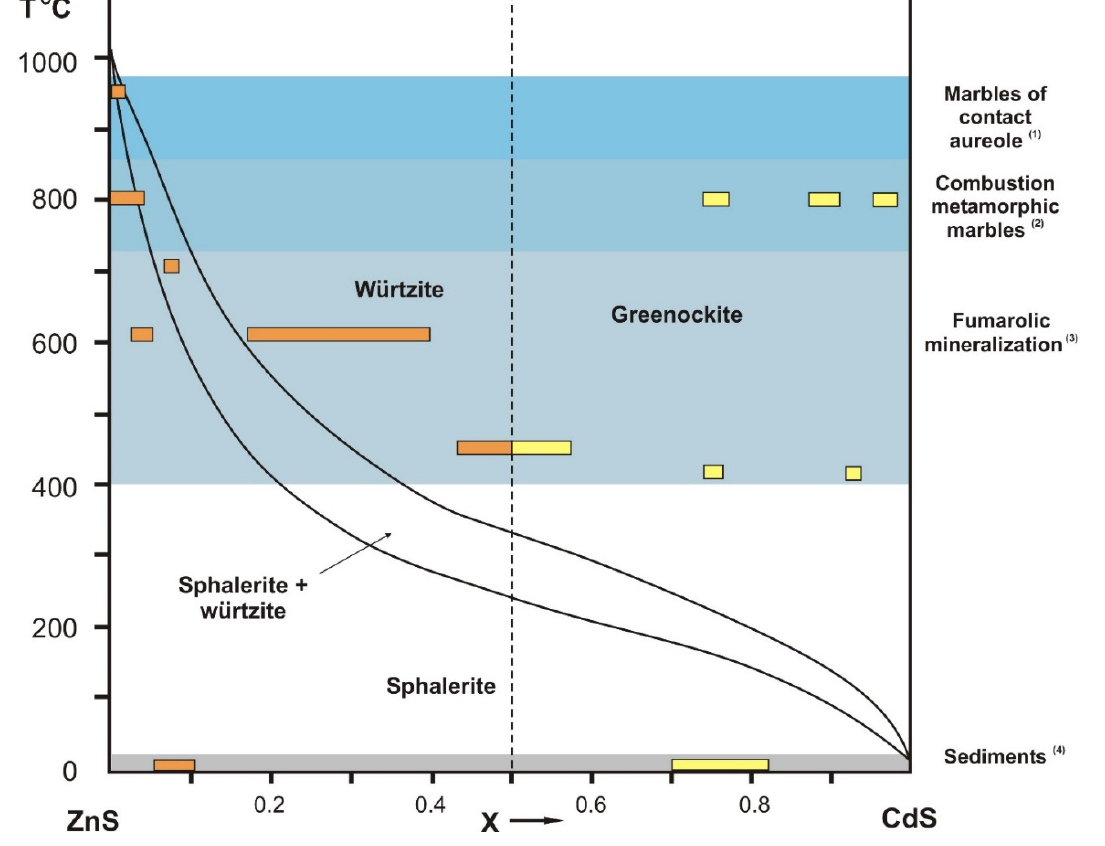
Figure 14. Phase diagram of the system ZnS–CdS; x—the molar fraction of Cd in Zn 1 − x Cd x S solid solution. Phase boundaries after [77]. Orange (sphalerite and würtzite) and yellow (greenockite) colors show the composition ranges of sulfides from different rock types: (1) spurrite marbles from Kochumdek contact aureole (Podkamennaya Tunguska Basin, East Siberia), after [73]; (2) CM marbles from Tulul Al Hammam area (Daba-Siwaqa complex, Central Jordan), this study; (3) fumarolic mineralization of Kudriavy volcano (Iturup Island, Kuriles), after [74]; (4) immature organic-rich siliceous chalks (‘oil shales’) of the Muwaqqar Chalk Marl Formation, after [14] and this work.